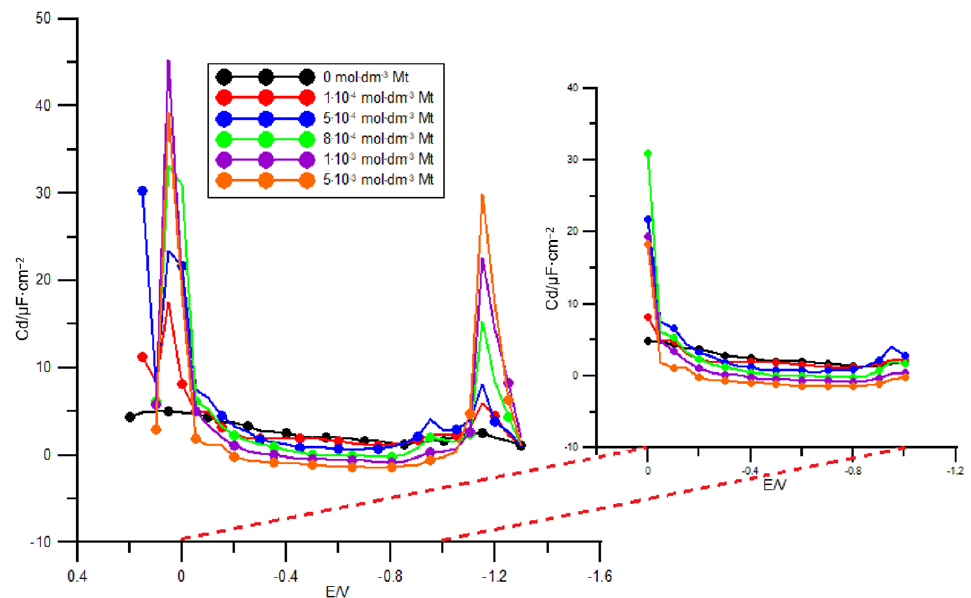
Figure 1. Differential capacity–potential curves of electric double layer at the R–AgLAFE/chlo- rate(VII) solution interface in the absence and in the presence of increasing concentration of methi- onine. The values of the methionine concentration are given in the plot.